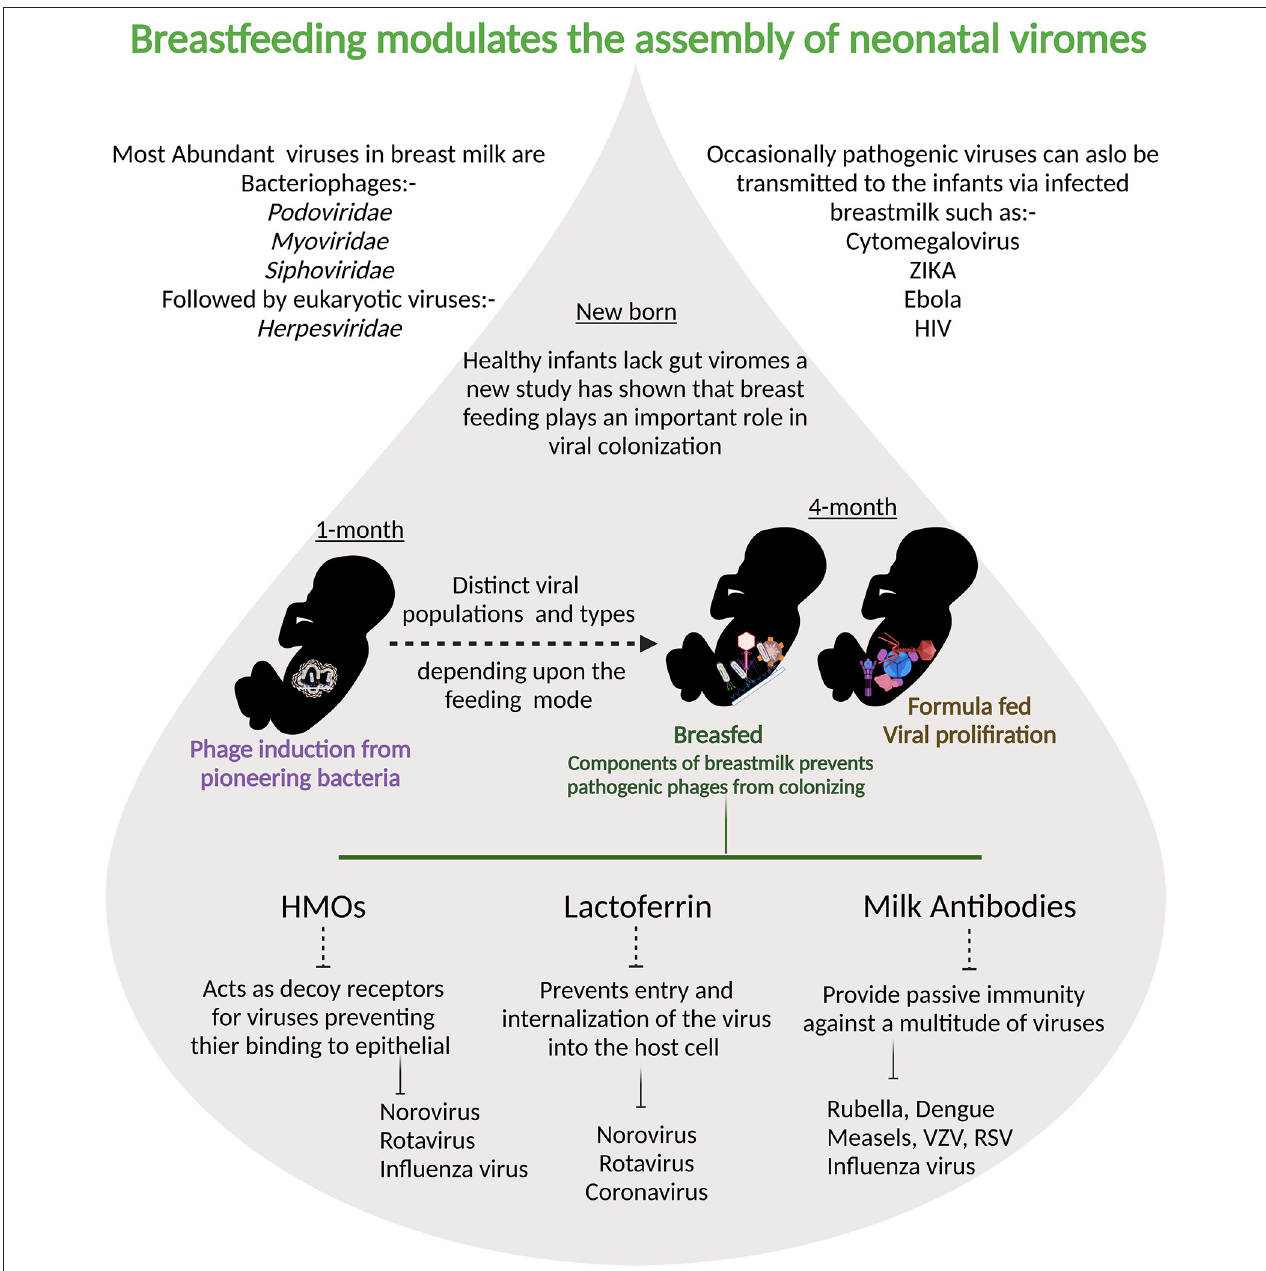
FIGURE 3 | Breastmilk ensures that fewer pathogenic viruses colonize infant intestine: at one month prophages are induced from the pioneering bacteria providing the first population of virus-like particles. By four months of life, multiple human viruses are abundantly detected in stool samples from babies.Viral populations differ depending on the feeding mode and components of breast milk are protective against viral